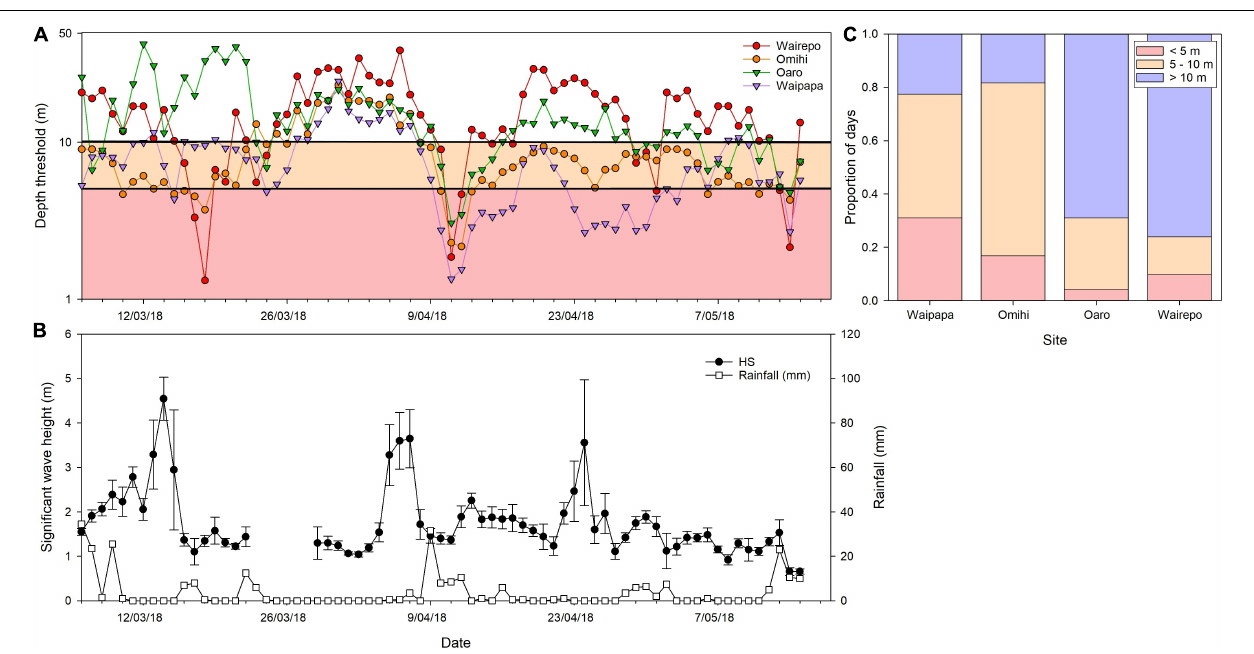
FIGURE 4 | (A) Maximum depth threshold for Durvillaea antarctica/poha (as estimated by compensating irradiance) based on measured PAR at multiple sites, (B) associated timing of wave events and rainfall, and (C) the proportion of days where the light availability depth threshold for Durvillaea antarctica/poha is below 10 and 5 m. Depth threshold (A) is log transformed.